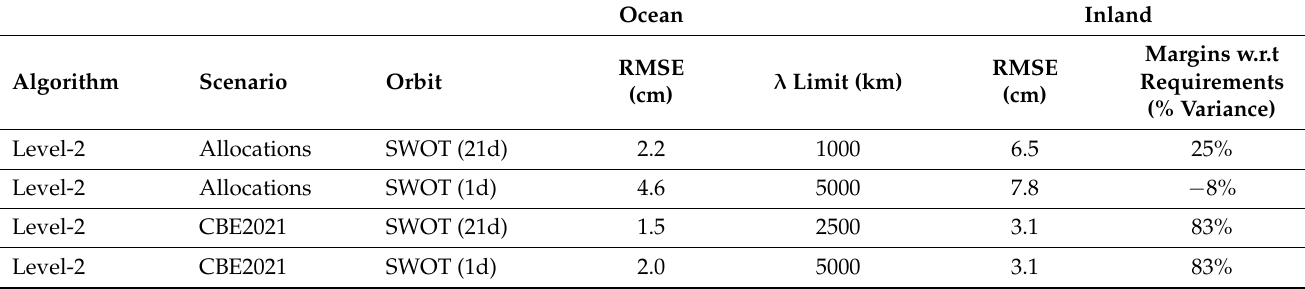
Table 2. Overview of the global Level-2 performance after data-driven calibration for different scenarios. The left columns are for the global ocean (sea-ice regions are excluded) with the Root Mean Square Error (RMSE) in cm and the wavelength λ where the calibration stops to be beneficial (measured from the power spectra below). The right columns are for the inland regions with the RMSE in cm and the margins with respect to the hydrology requirements (expressed in % of variance). Ocean